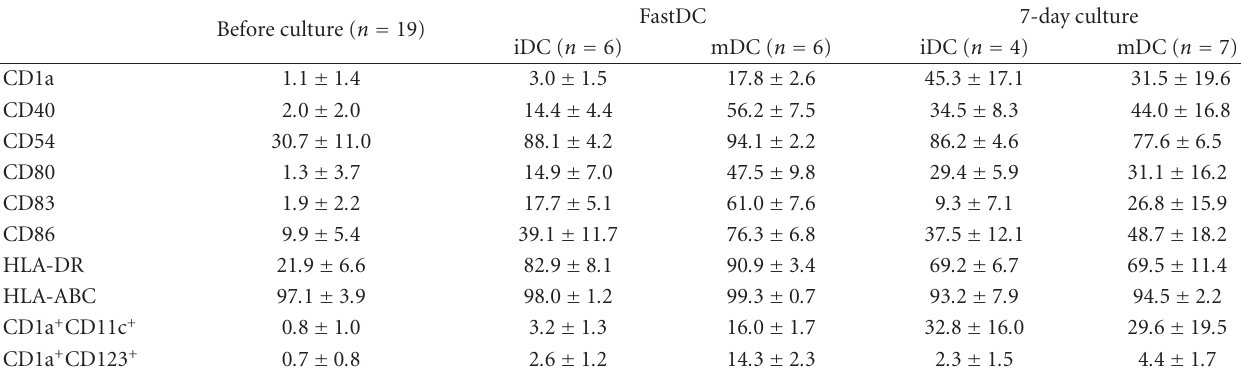
Figure 1: DLC phenotypes of KG-1 cells. KG-1 cells were culture to generate DLC using FastDC and 7-day culture methods. The phenotypes were monitored at immature (iDLC) and mature (mDLC) stages in each culture. Data are representative of at least three samples. Shaded histograms are isotype controls and unshaded histograms represent marker expression. Table 1: Cell phenotypes of DC generated from PBMC using FastDC and 7-day culture methods. The results were the percentages of positive stained cells in gated cells after subtraction of the appropriate values of isotype controls. Results are shown as mean ± SD, where n is the total sample number